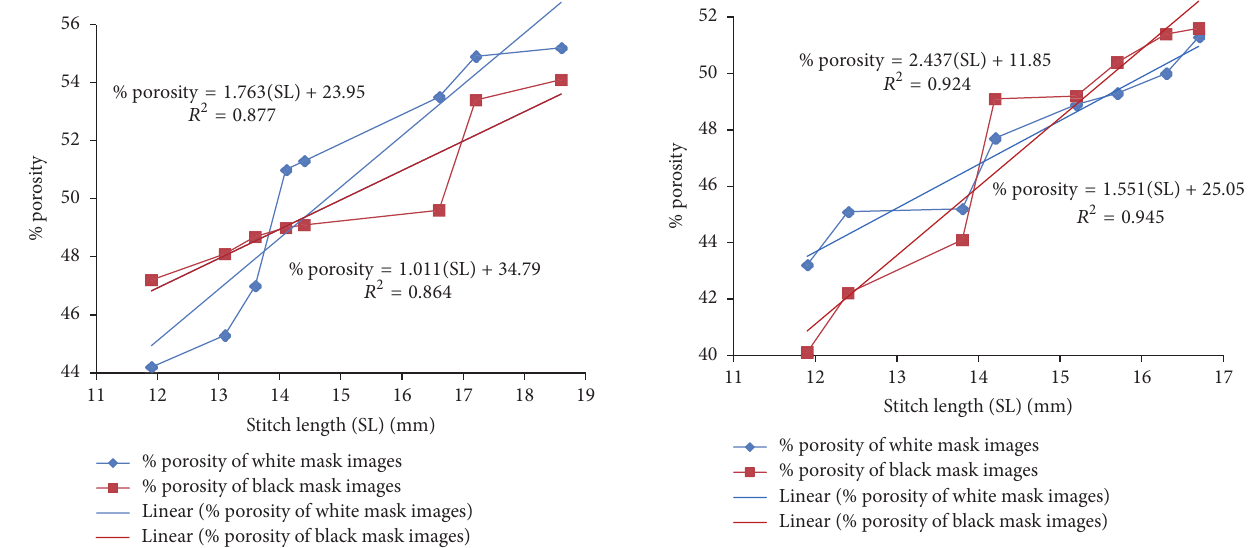
Figure 9: Percentage porosity against stitch length (SL) for rib 2 × 1 for FKM.